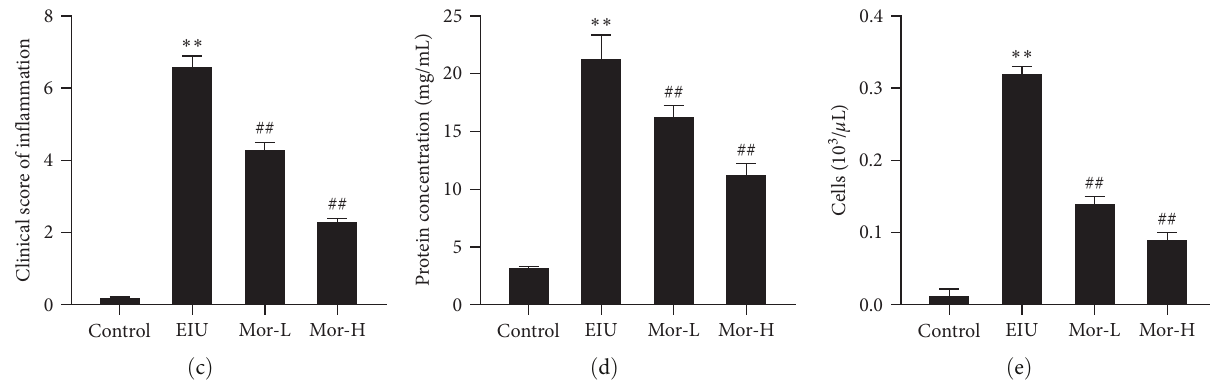
F IGURE 1: Effect of morroniside on intraocular in fl ammation and histopathology in EIU mice. (a) In fl ammation in each group under slit lamp microscopy at 24hr after LPS injection (front and lateral views). (b) Observation of HE staining patterns in the anterior chamber, iris, ciliary body, vitreous cavity, and retinal tissues (100 × , scale bar, 200 μ m). (c) The clinical score in each group at 24hr after LPS challenge. (d) The number of in fl ammatory cells in the aqueous humor was counted after 24hr. (e) The protein concentrations in the aqueous humor were measured after 24 hr. Mean Æ SD from three independent samples are shown. Comparison with the control group: ∗∗ P < 0 : 01. Comparison with the EIU group: # P < 0 : 05, ## P < 0 :